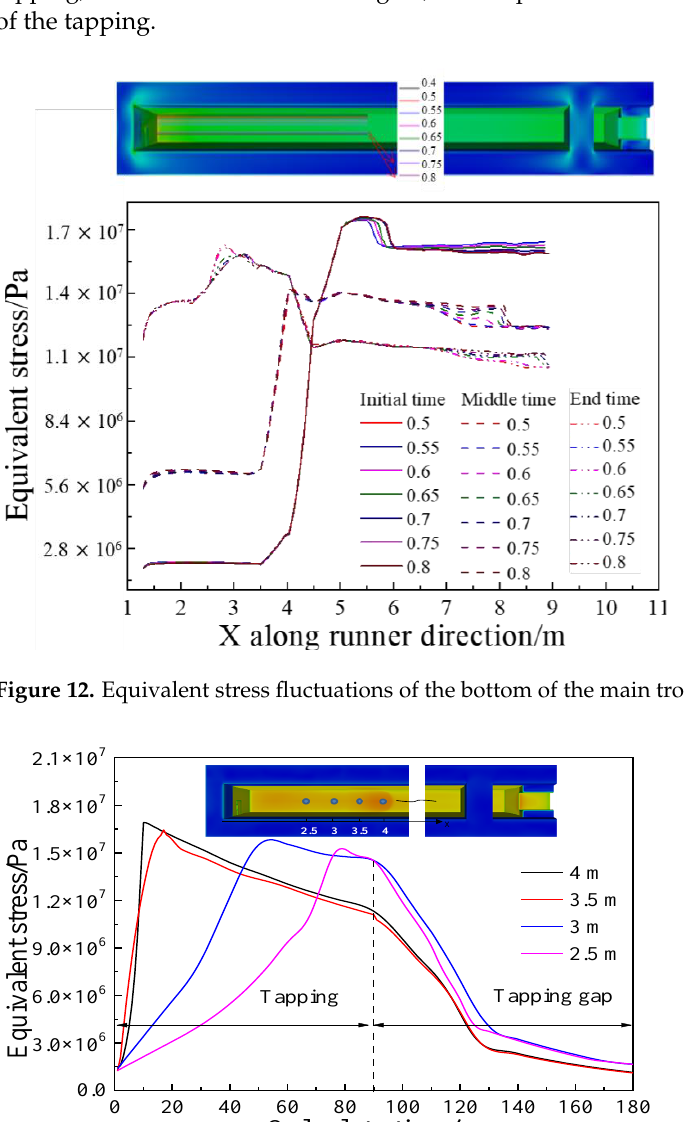
14 of 24 the center to the sidewall, the thermal stress at different positions is not much different. In the early stage of the tapping, the thermal stress downstream is very large and the stress